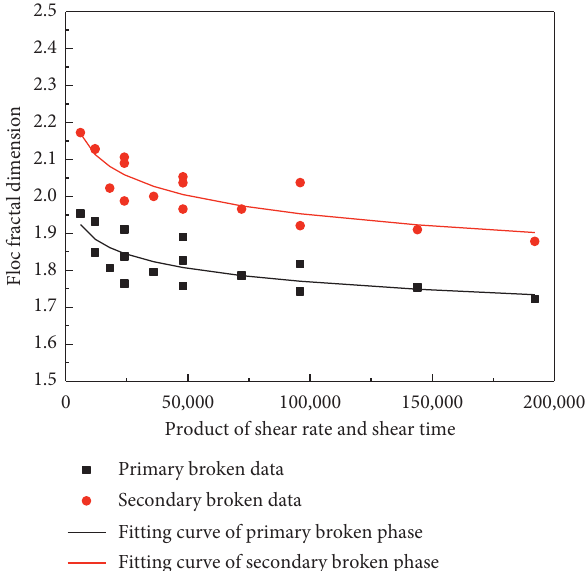
Figure 13: The variation of floc fractal dimension with the product of shear rate and shear time in the primary and secondary broken phases.